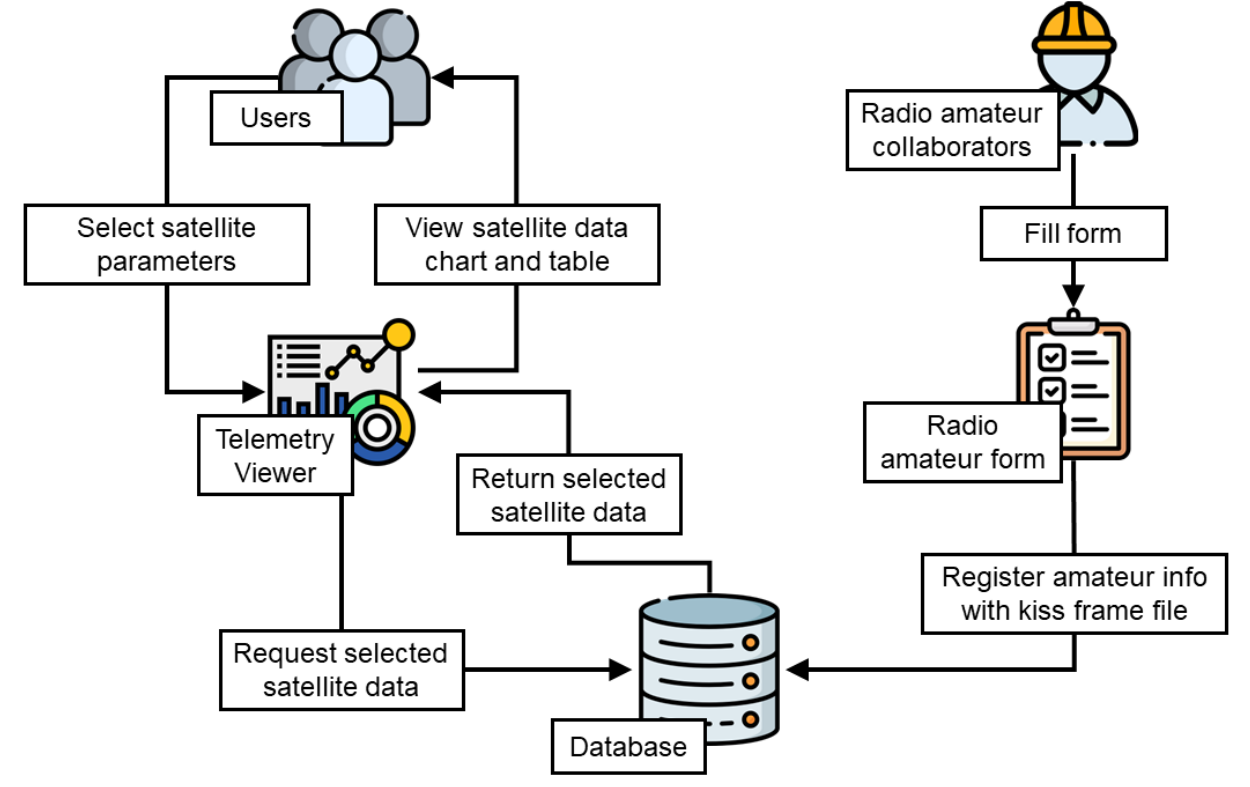
Figure 12. User segment architecture: data management and